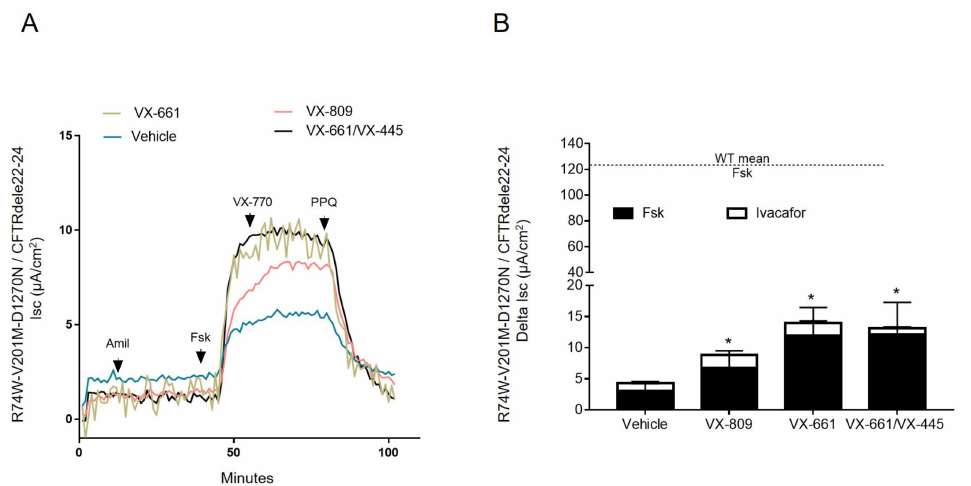
Figure 4. Electrophysiological response of the 2D monolayer of [R74W;V201M;D1270N]/CFTRdele22_24 colonoids. ( A ) Representative Isc tracing of anion secretion mediated by CFTR in colonoids prein- cubated with vehicle (dimethyl sulfoxide: DMSO) and the indicated CFTR modulators, following challenge with forskolin and ivacaftor; ( B ) Magnitude of response expressed as delta Isc response of cAMP-induced chloride currents by forskolin and ivacaftor in the 2D monolayer of rectal epithelial organoids preincubated with the indicated CFTR modulators. The dotted line indicates the mean value (123 ± 45 µ A/cm 2 ) of currents registered for non-CF subjects (WT) in response to forskolin, used here as a reference. Values were normalized by the surface area of the 2D filters. Data are means ± SEM from a minimum of three independent experiments. * indicates p < 0.05. Mann–Whitney test.